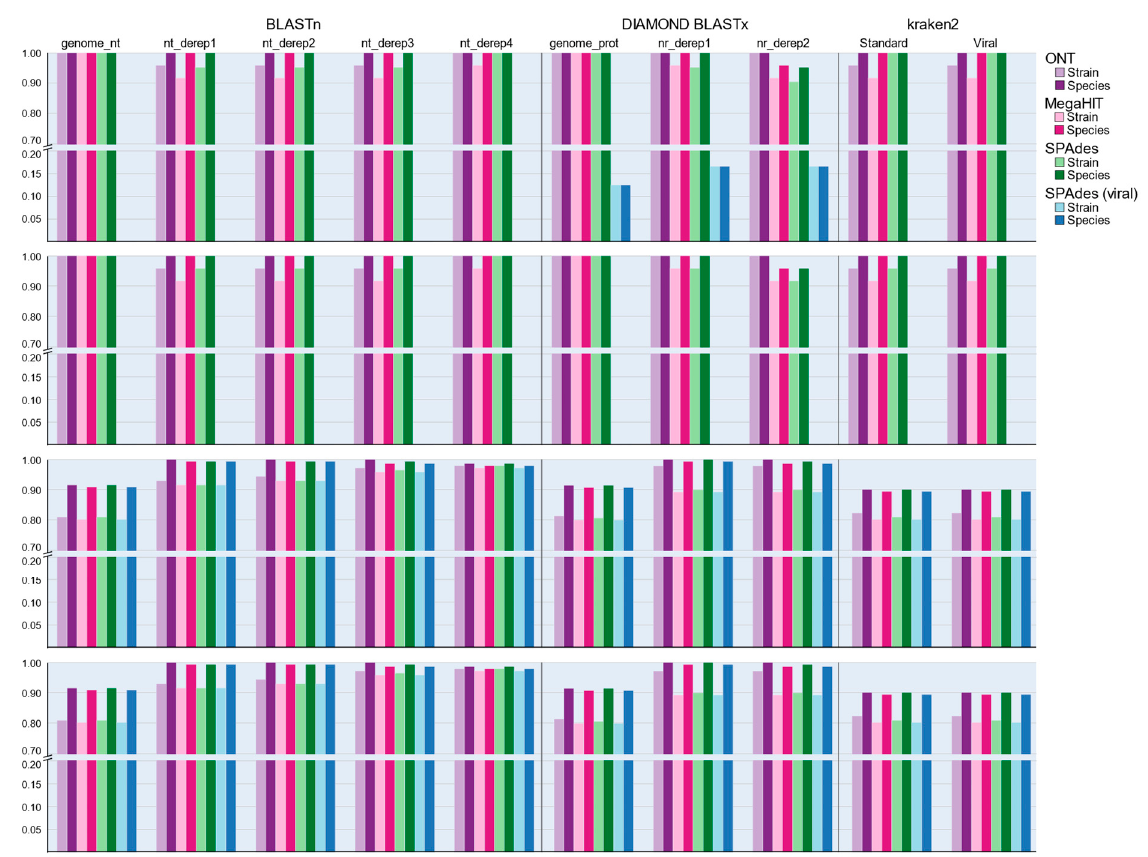
Figure 4. The rate of successful detections at either the strain or species level for each mock library analysis options for nucleic acid classification tool. Sequence sensitivity for each tool and database combination is reported as the proportion of successful identification events across all samples for the given sequencing platform, as assessed at strain- or species-level resolution.